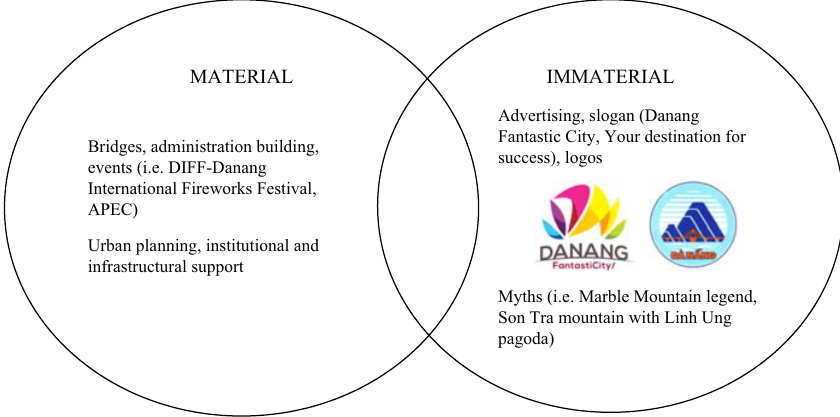
Figure 1. Danang Urban branding